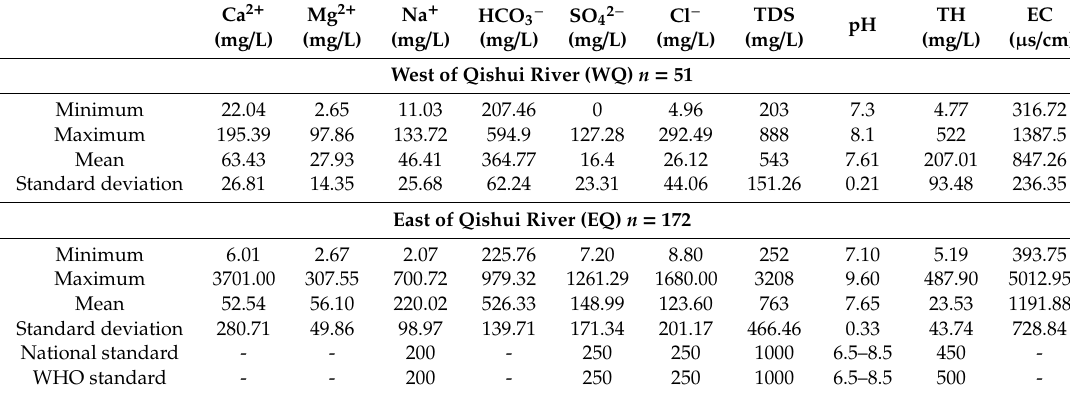
Table 1. Physicochemical groundwater characteristics. EC: electrical conductivity; TDS: total dissolved solids; WHO: World Health